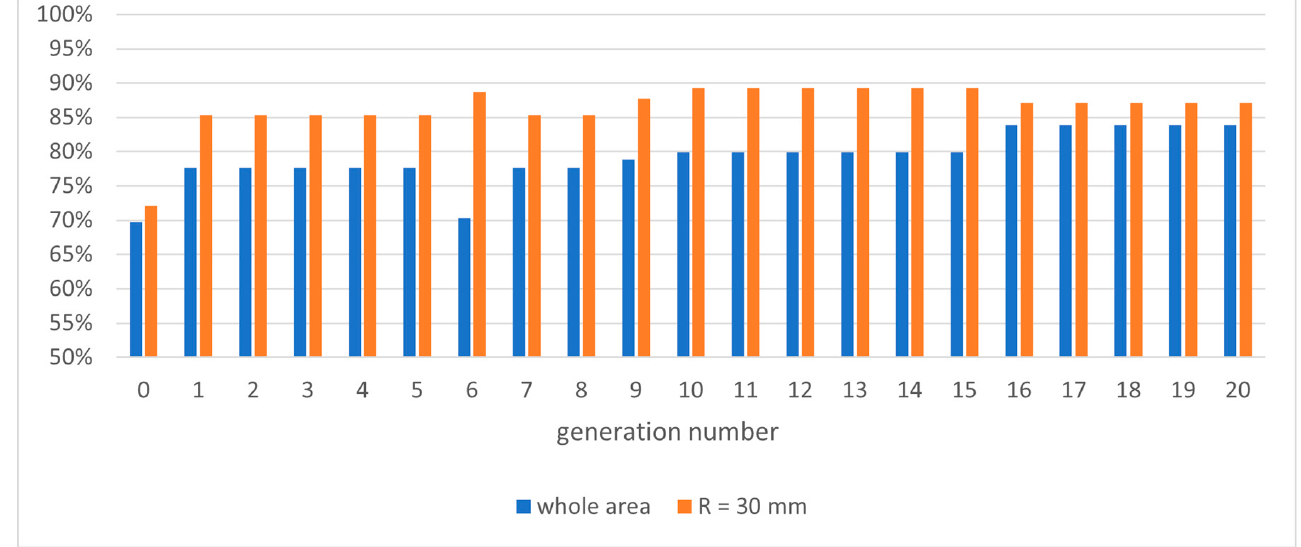
Figure 7. The share of correctly classified markers for the entire pattern and in the area of radius R = 30 mm around the center of the marker grid, depending on the number of generations for 400 individuals and the adaptation function for the area in radius r = 30 mm around the center of the grid.